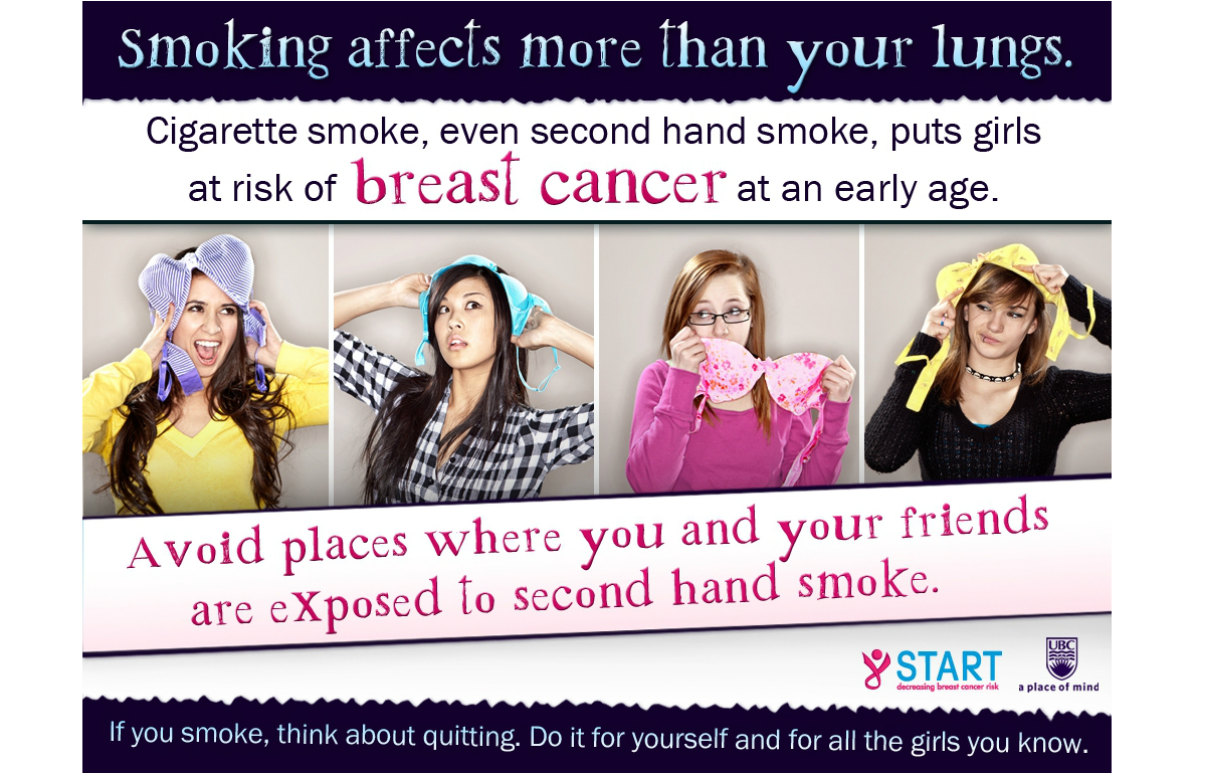
Figure 1. Gender-targeted intervention message for girls. Source: Created by START study authors, who hold copyright to the image.